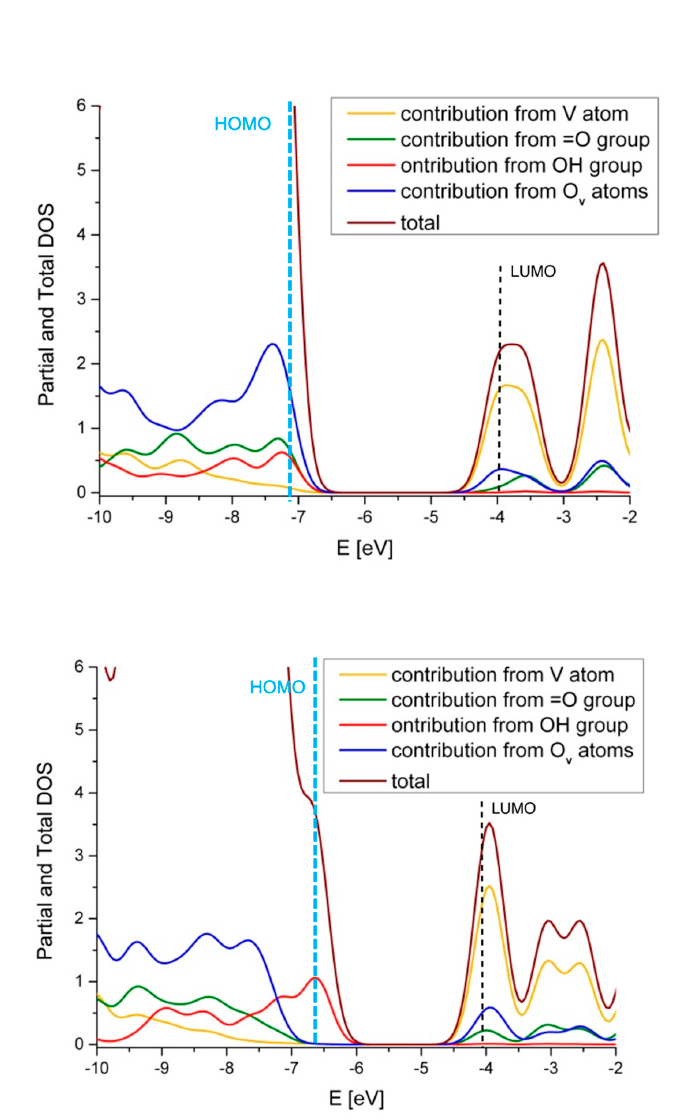
Figure 6. DOS plot of the V=O center in ( a ) T2 and ( b ) T3 positions.